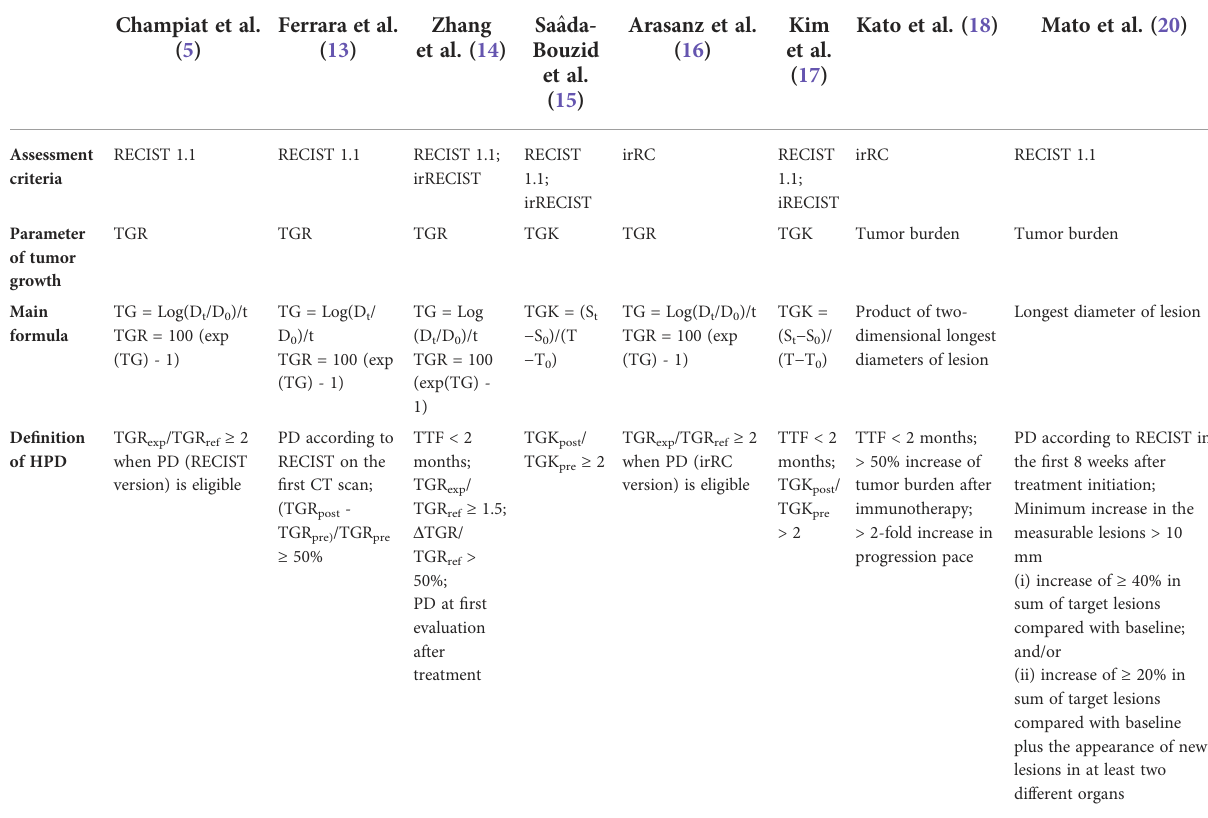
TABLE 1 Representative de fi nition of hyperprogressive disease in different clinical